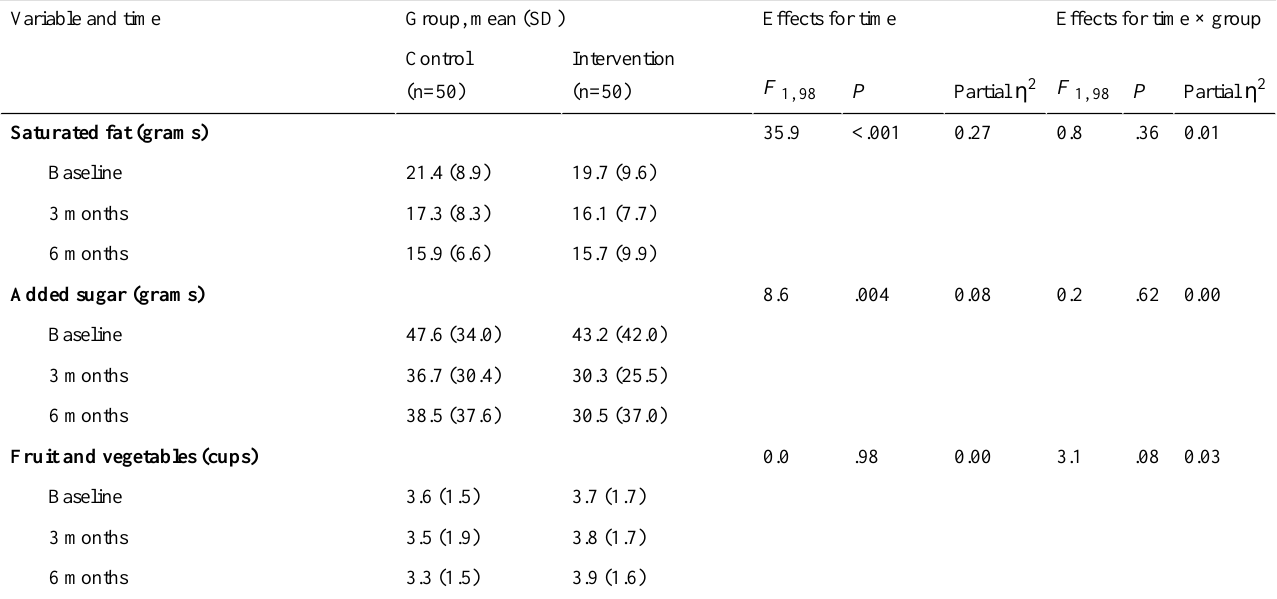
Table 2. Means (SDs) and results from ANOVA models for intake of saturated fat, added sugar, and fruit and vegetables at baseline, 3 months, and 6 months in the intervention and control groups, for the intention-to-treat analysis.